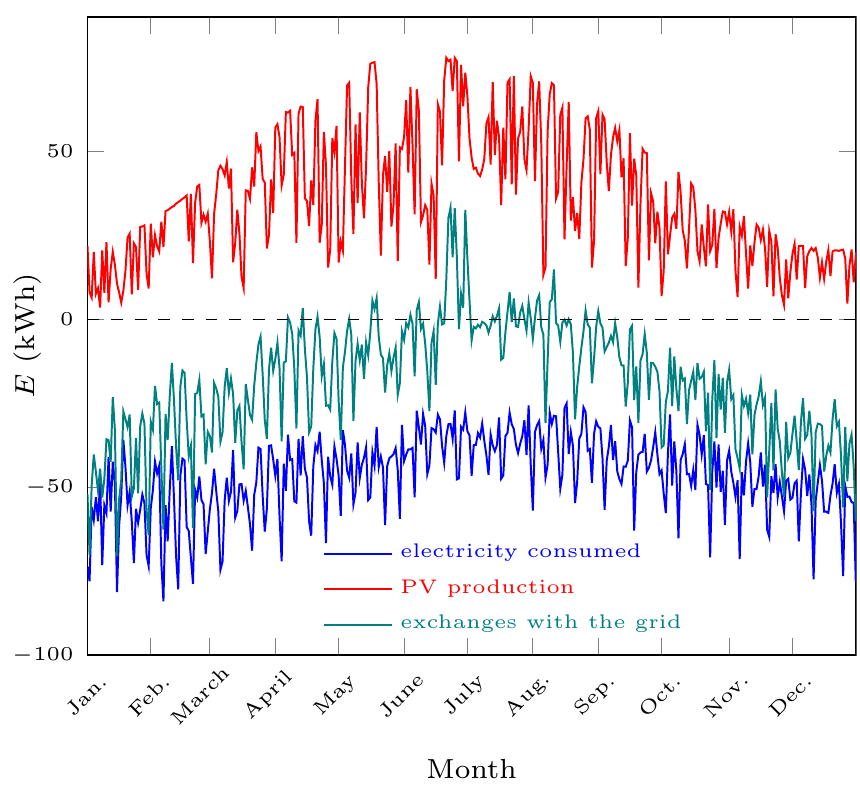
Figure 4. Energy flows in the first case over one year, on a daily basis, from January to December. Overall, some observations can be made. In a connected grid, storage is still too